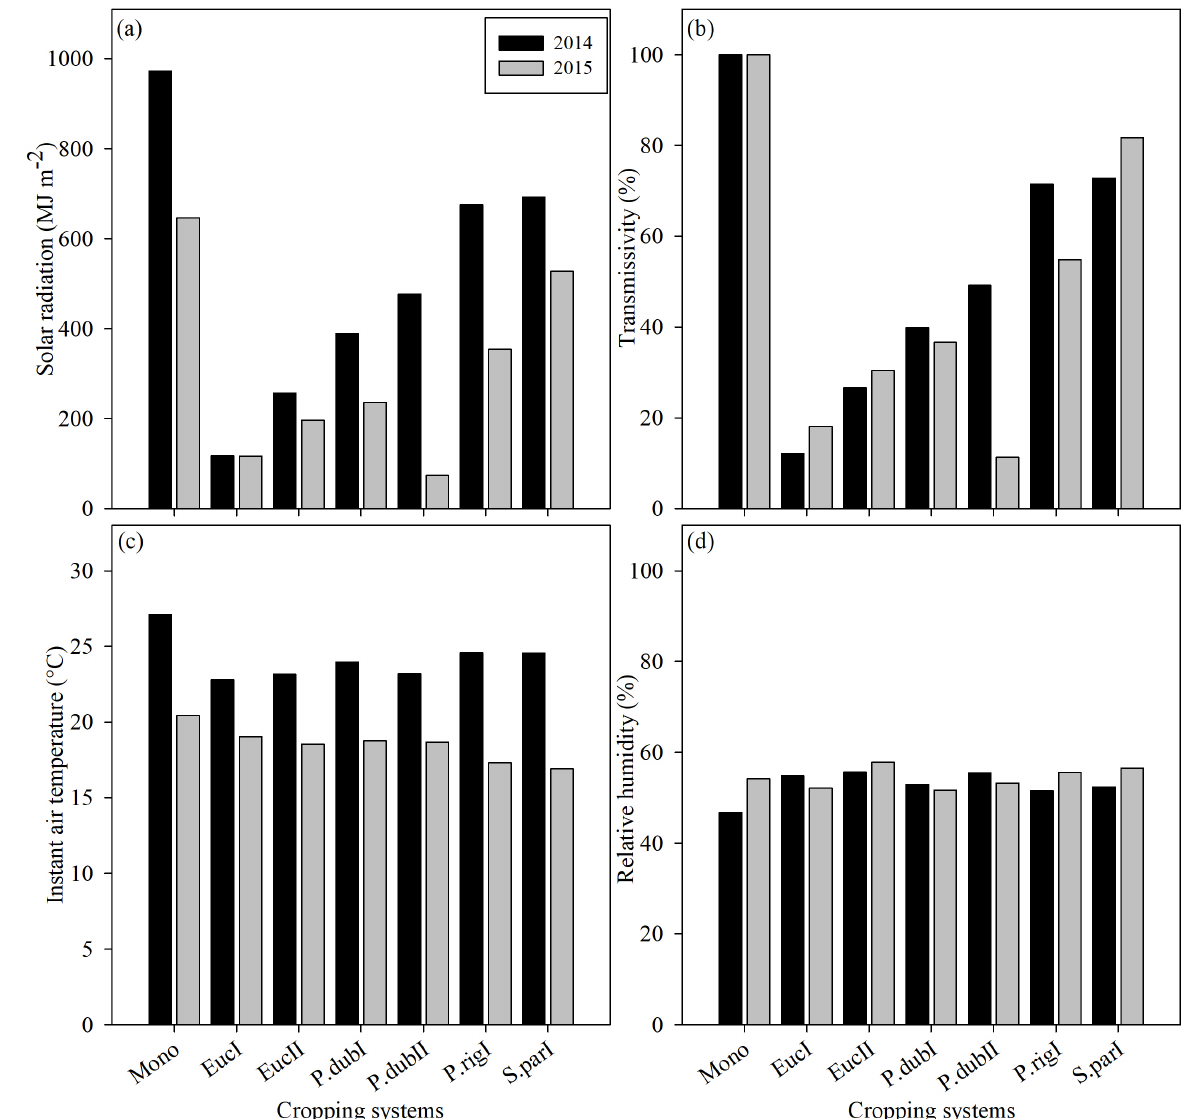
Figure 4 - Incident global solar radiation (a) transmissivity of solar radiation (b) air temperature (c) relative humidity (d) in different cropping systems in the crop years 2014 and 2015 (Crop Season I and II, respectively). Each bar represents an evaluation point. (Mono): Monoculture; ( S.par I): Schizolobium parahyba in Intercrop-I; ( P.rig I): Parapiptadenia rigida in